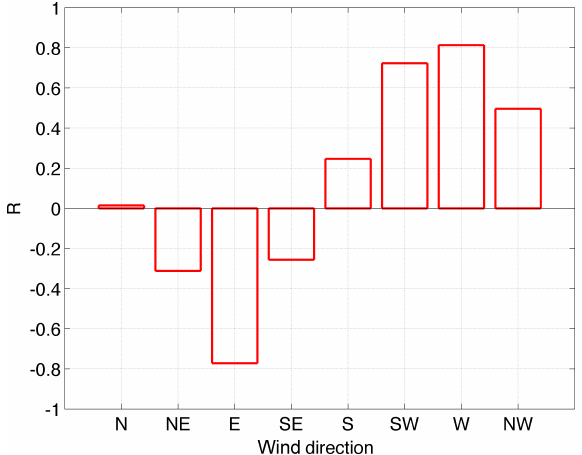
Figure 6. Correlation coefficient R , based on a 20-year record, representing the correlation between annual mean sea level at Den Helder (Fig. 2) and annual aggregate wind energy for each of the eight sectors, calculated from the wind record at Vlieland weather station (Fig.